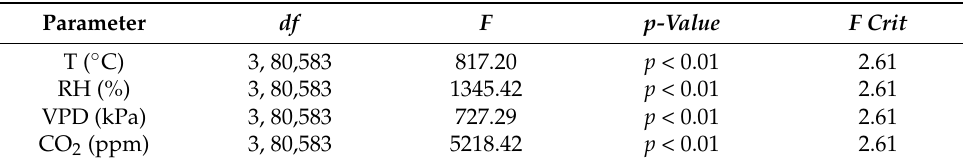
Table 11. ANOVA results for T, RH, VPD, and CO 2 distribution in the fifteen-span greenhouse. T: air temperature; RH: relative humidity; T dp : dew point temperature; VPD: vapor pressure deficit; CO 2 : carbon dioxide.